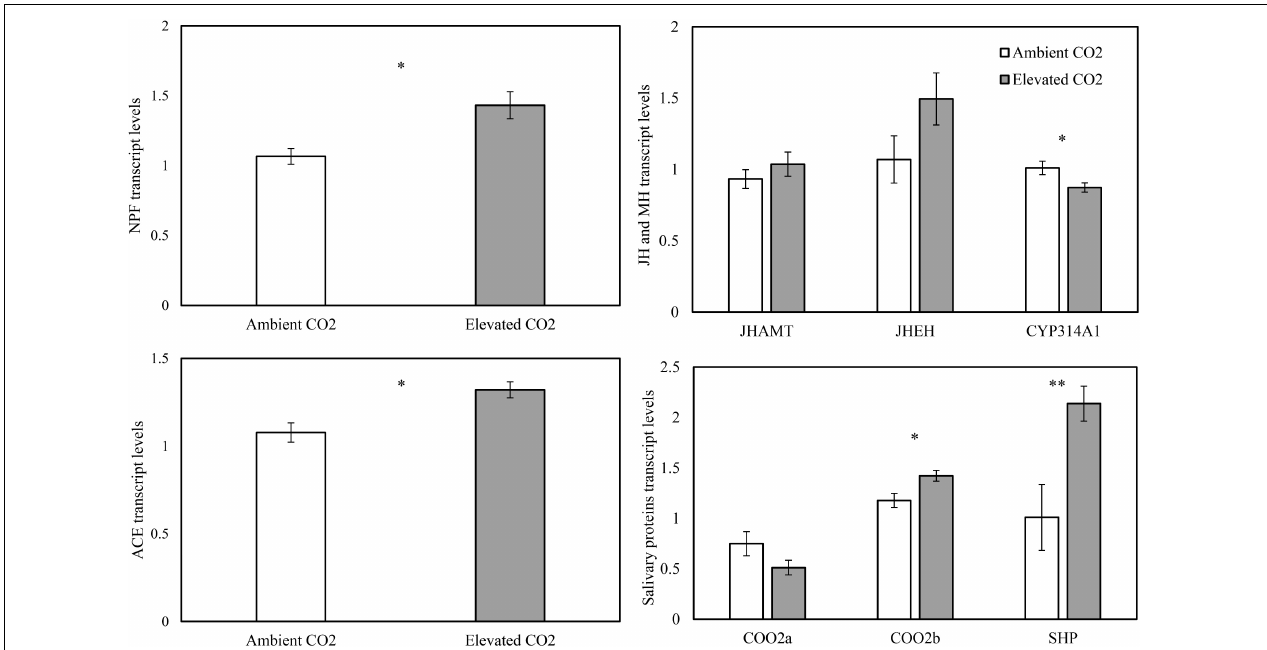
FIGURE 4 | Relative transcript levels (Mean ± SE) of the appetite genes of neuropeptide F (NPF) and angiotensin converting enzyme (ACE), the salivary protein genes of C002a, C002b, and salivary sheath protein (SHP), and the molting hormone (MH) gene of CYP314A1, and the juvenile hormone (JH) (JH) genes of JHAMT and JHEH of the cotton aphid, Aphis gossypii fed on the fully expanded leaves excised from the 35- to 60-day-old cotton seedlings grown under ambient and elevated CO 2 (Asterisks indicate a significant difference between the treatments of ambient and elevated CO 2 by the LSD test at P <